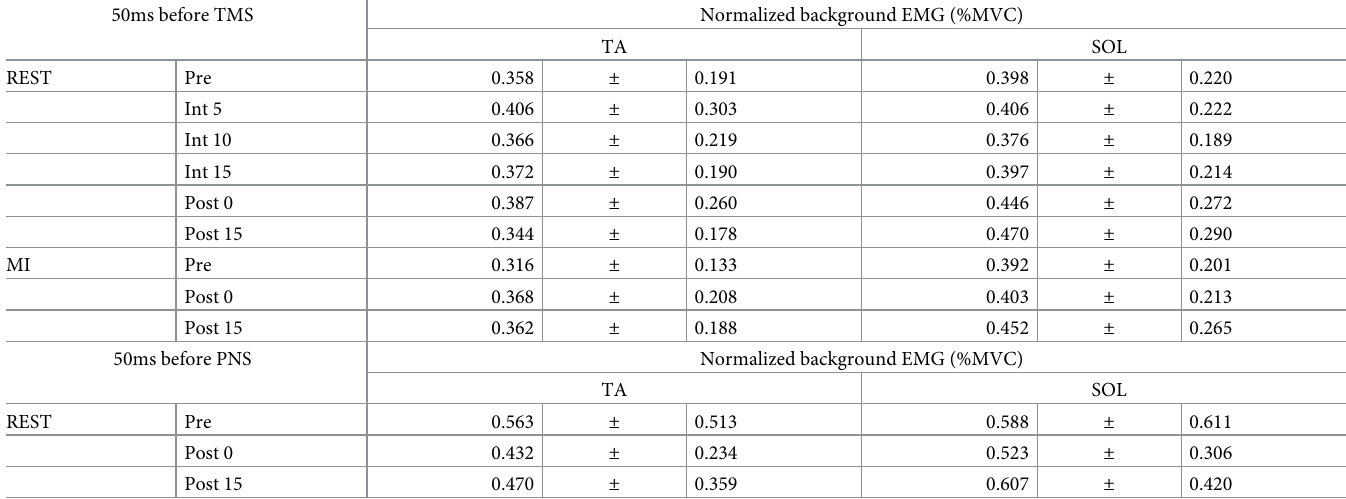
Table 5. Average normalized background EMG activity (% of MVC) with SDs in the TA and SOL muscles, 50 ms before TMS and PNS in each measurement. 50ms before